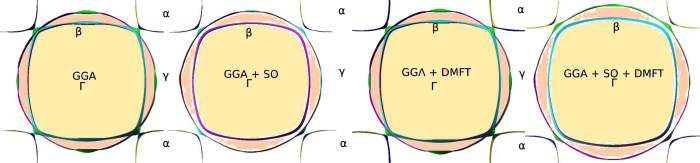
Fermi surfaces for Sr2RuO4 calculated using GGA, GGA + SO, GGA + DMFT, GGA + SO + DMFT.In consistency with the band structure we show the α, β and γ Fermi sheets and the high symmetry Γ point. In agreement with Zhang et al., We find that SOC is essential to derive the quantitatively correct Fermi sheets as seen in dHvA experiment of Bergemann et al.